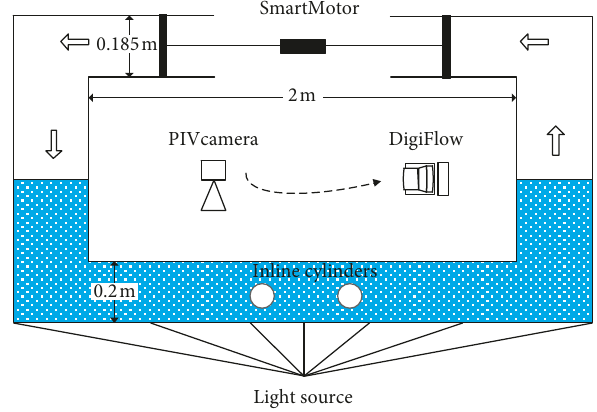
Figure 1: Sketch of experiment